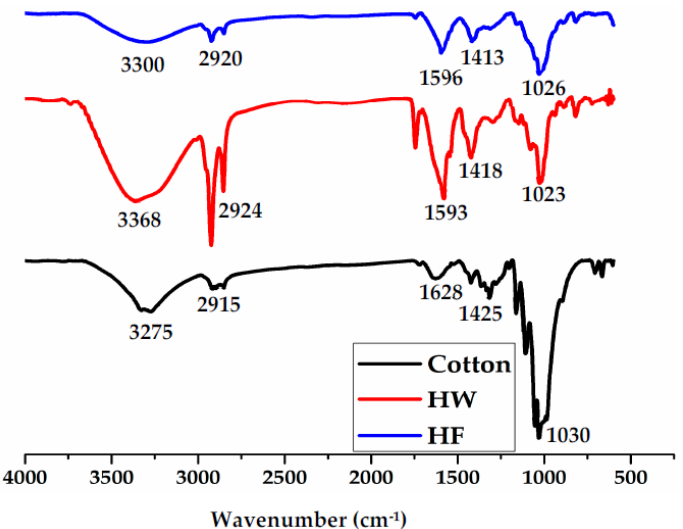
Figure 5. FTIR spectra of pure cotton fibers, Pure alginate hydrogel fibers (HW), and cotton reinforced alginate hydrogel fibers (HF).